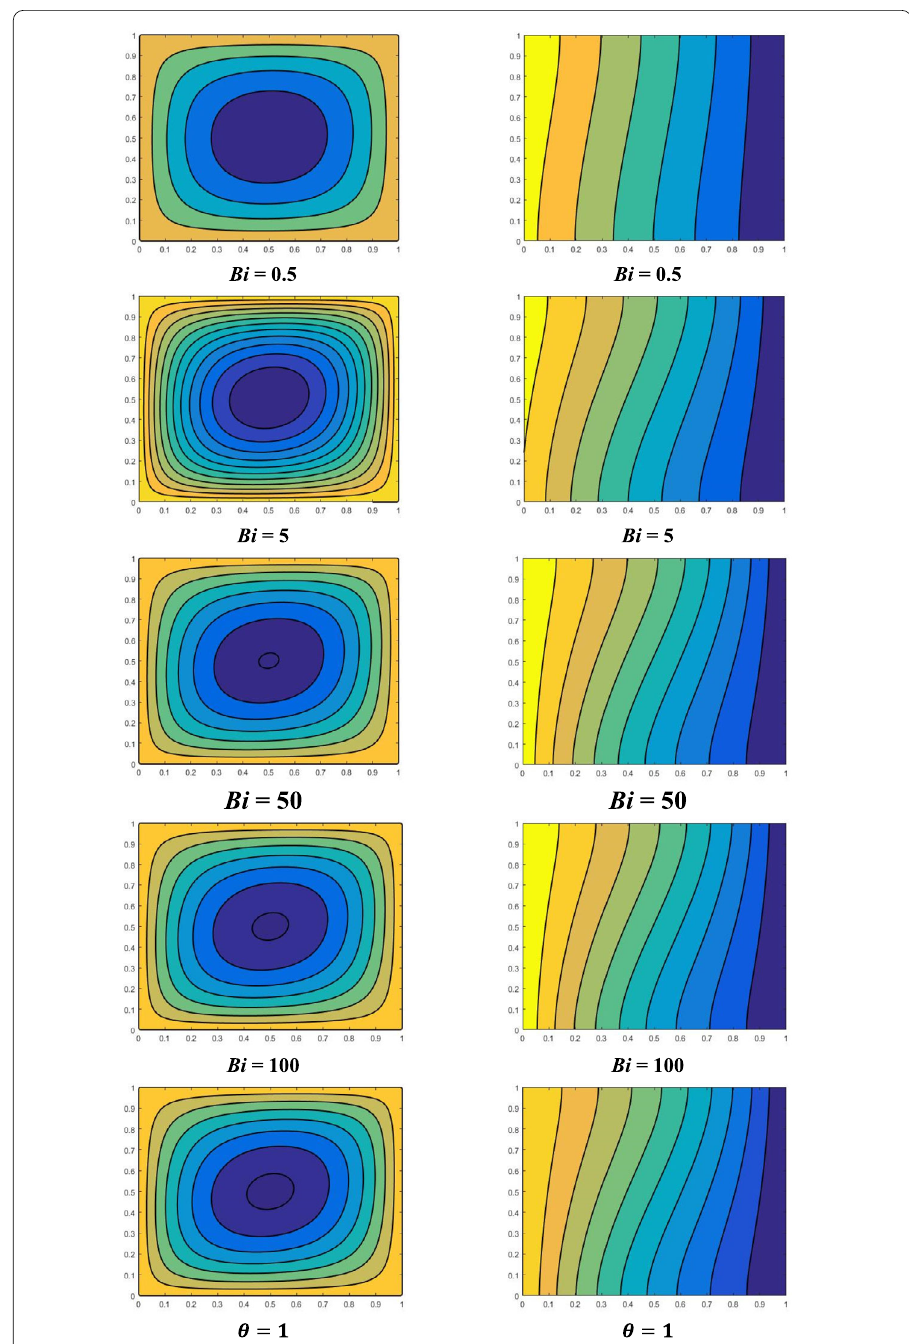
Figure 3 Streamlines (first column) and isotherms (second column), Ra = 10